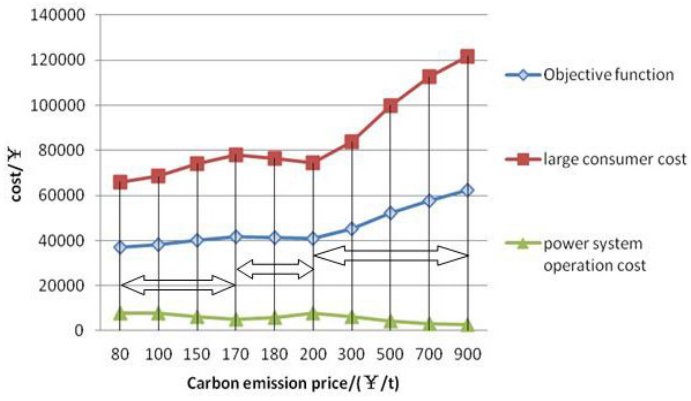
Figure 4. The variation tendency of the objective function, the large consumer cost and the power system operation cost.